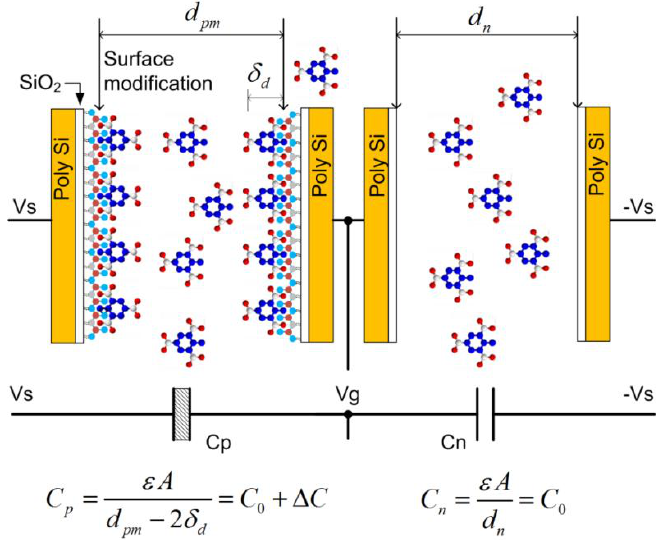
Figure 7. Principle of vapour traces detection of target molecules using a pair of differently functionalised comb capacitors. The chemical asymmetry of the capacitors’ electrodes results in the asymmetry of the capacitance due to the preferential adsorption of target molecules on functionalized